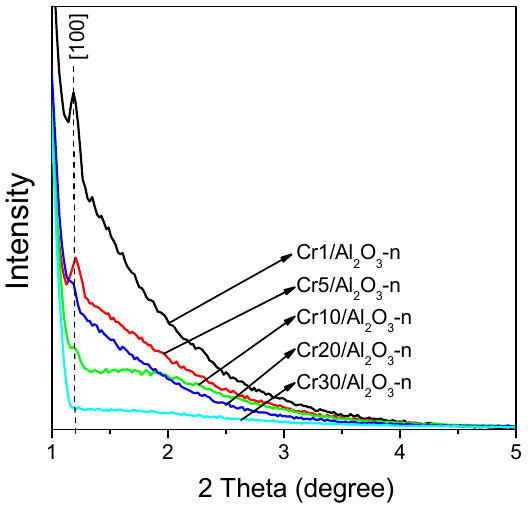
Figure 2. X-ray diffraction patterns of chromium oxide catalysts.